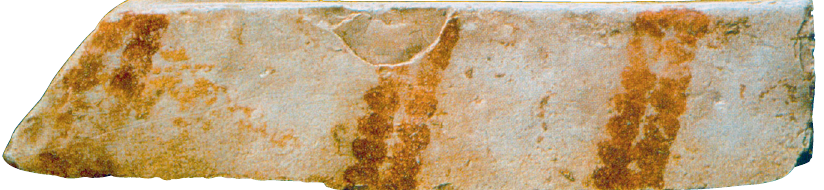
Figure 11. Hohle Fels, painted chalk stone from J. Hahn’s excavations. Photo: H. Jensen, Univ. Tübingen.